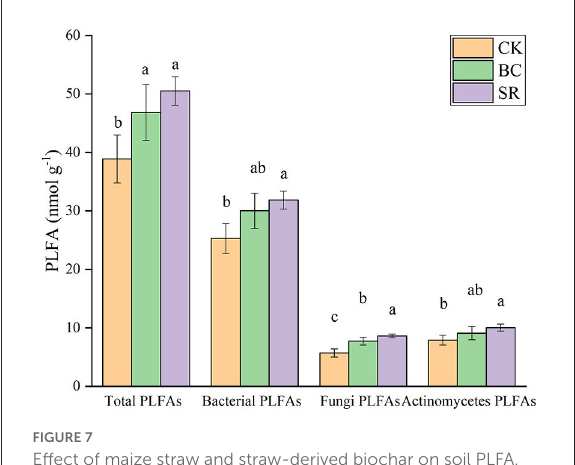
FIGURE7 Effect of maize straw and straw-derived biochar on soil PLFA. The error bars represent the standard deviations of the mean values ( n = 3). Different lowercase letters indicate significant differences between the different treatments. PLFA, phospholipid fatty